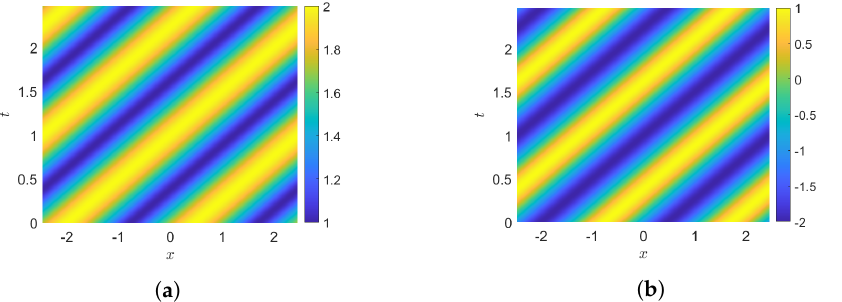
Figure 1. Elliptic cosine solution with α = 1, β = 2, V = 1.2, b = 5, a = 1.3, z 0 = 0, m = 0.5. ( a ). Short wave | S | . ( b ). Long wave L